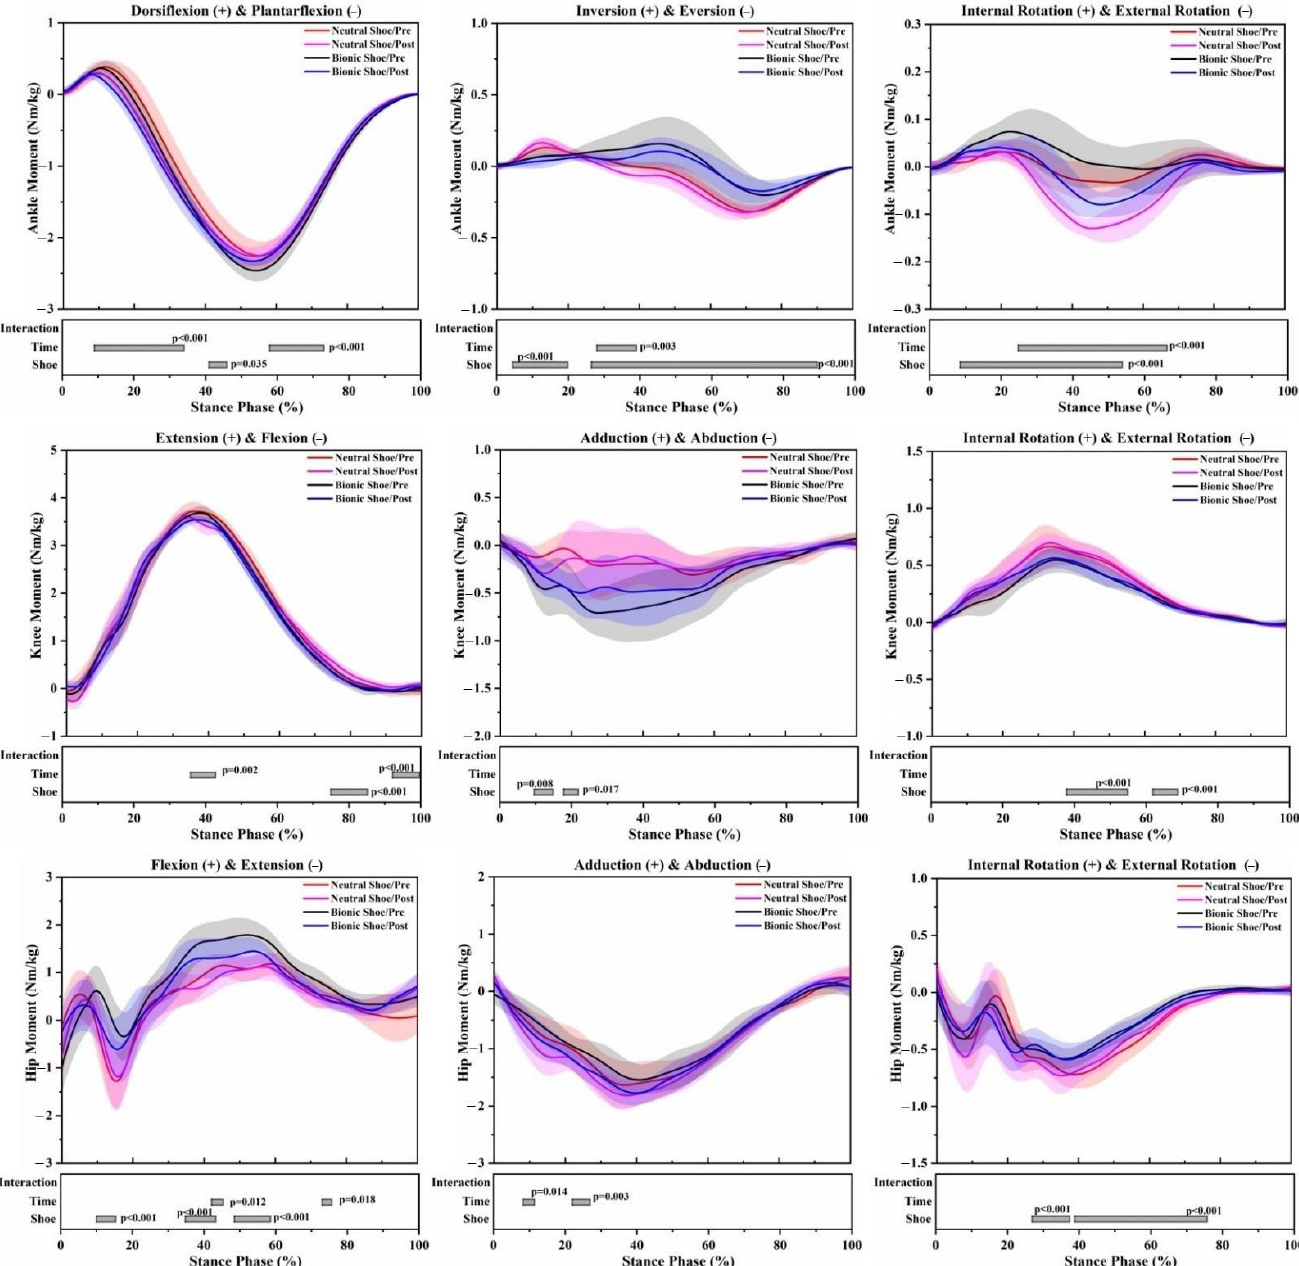
Figure 4. Lower limb joint moment waveforms of mean and standard deviation over the stance phase of 4 running conditions. Significant main effects of the shoe, time and interaction ( p < 0.05) are highlighted (grey horizontal bars at the bottom of the figure) during corresponding periods from SPM1d analyses.